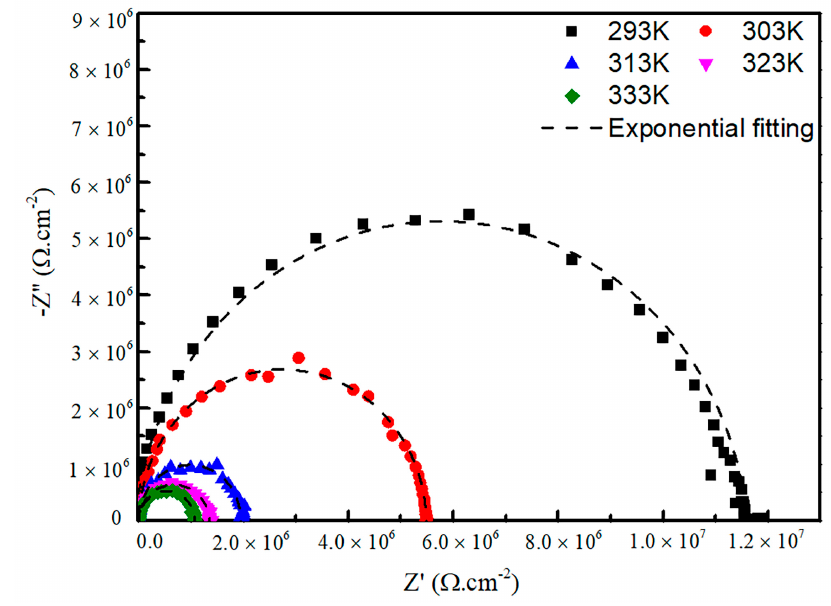
Figure 9. AC impedance of A11 glass at different temperatures.